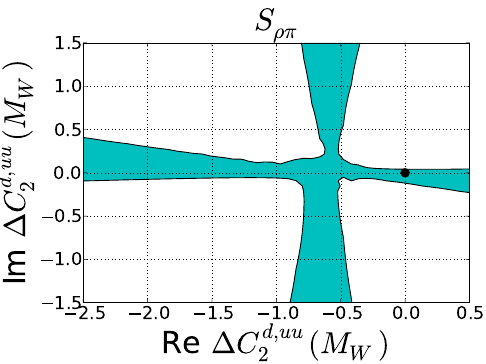
Figure 9 . Potential regions for the NP contributions in (cid:1) C d;uu S (cid:26)(cid:25) at 90% C.L., the shift in the Wilson coe(cid:14)cient (cid:1) C d;uu therefore not shown. The black point corresponds to the SM